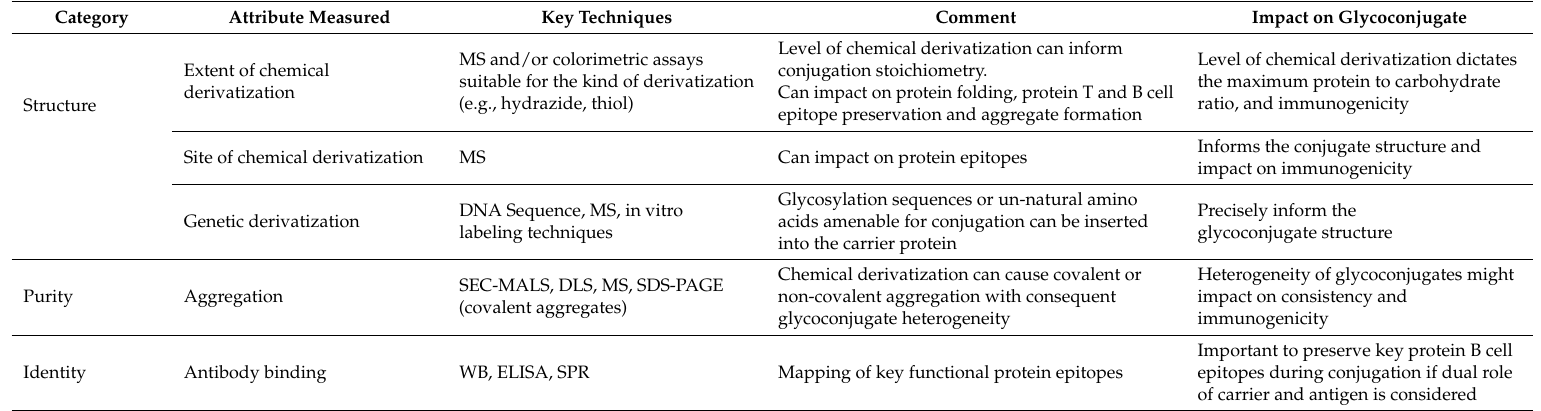
Table 2. Example of characterization approach for derivatized protein